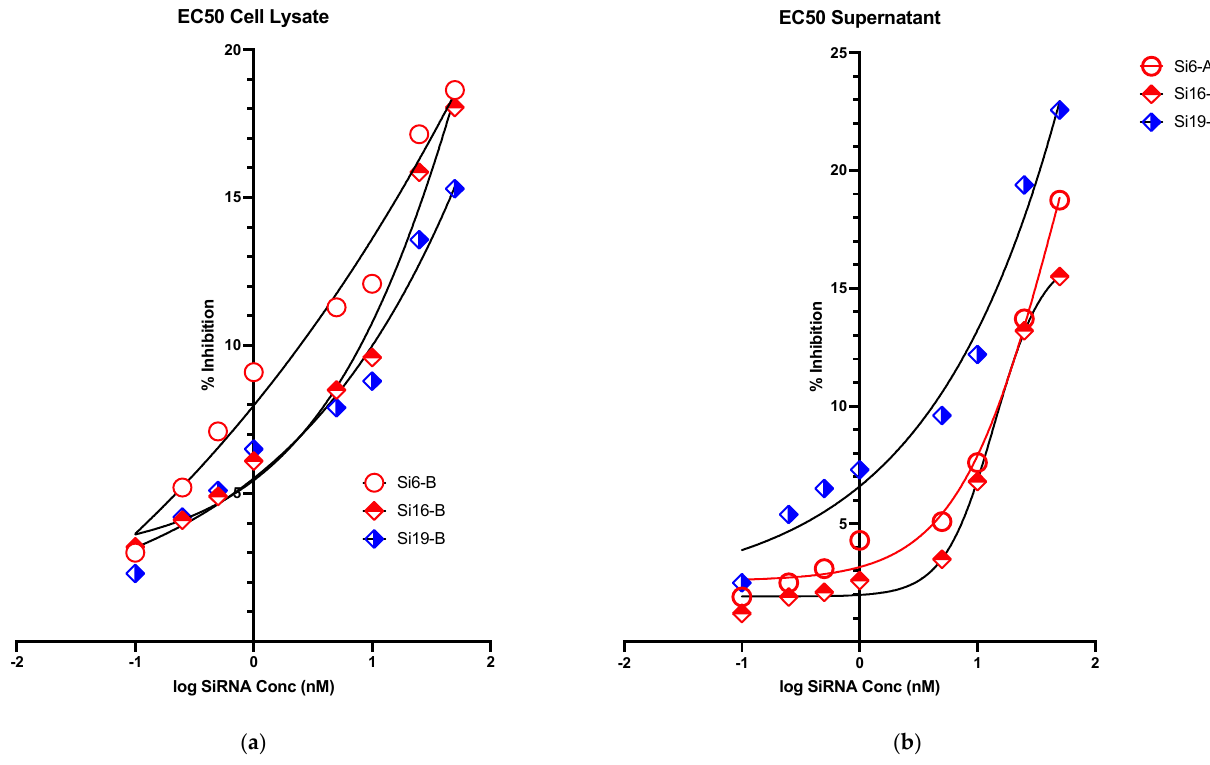
Figure 5. Graphical representation of Ct value of ( a ) real time-PCR result-cell lysate and ( b ) real time-PCR result-cell su- pernatant.